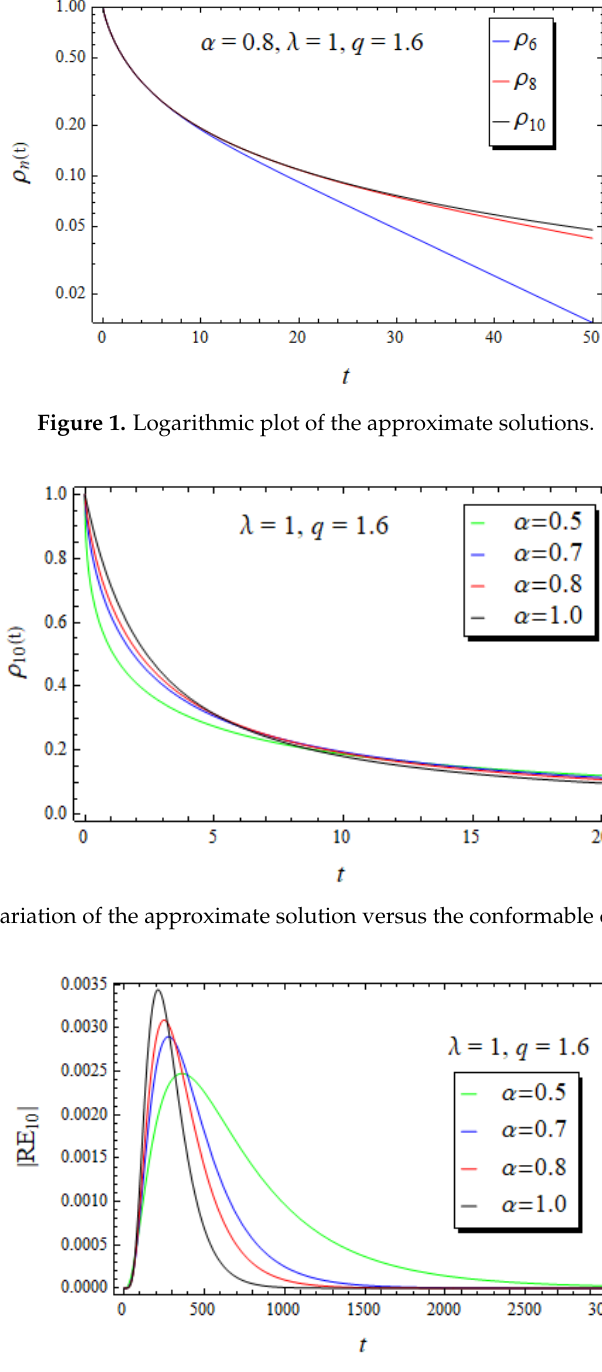
Figure 3. Effect of the conformable derivative order α on the residual at λ = 1, q =